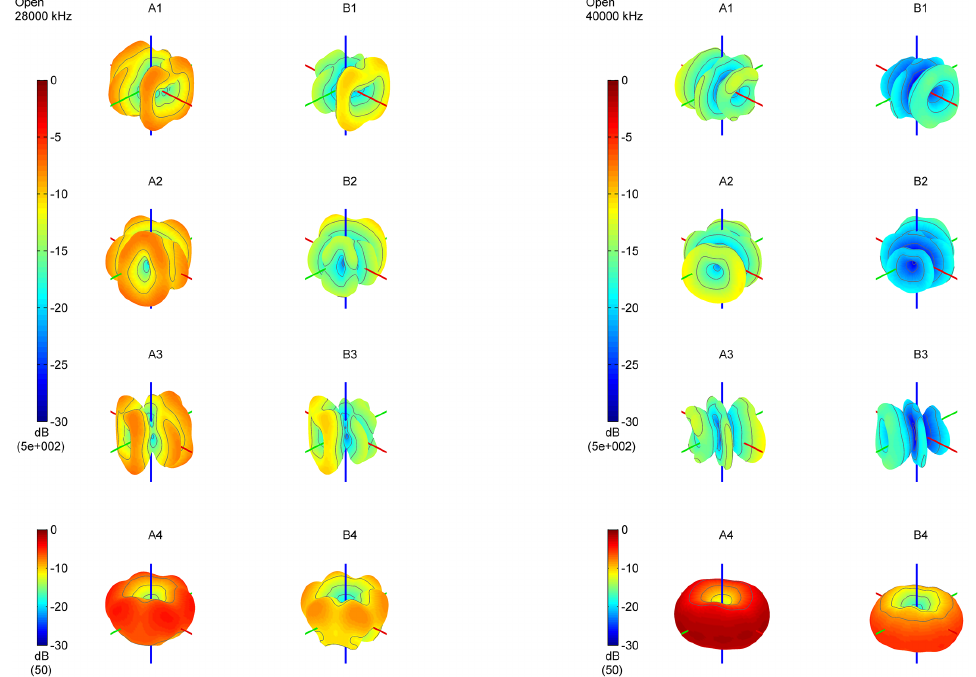
Figure 6. Effective area patterns analogous to Fig. 5, but for 28MHz (left) and 40MHz